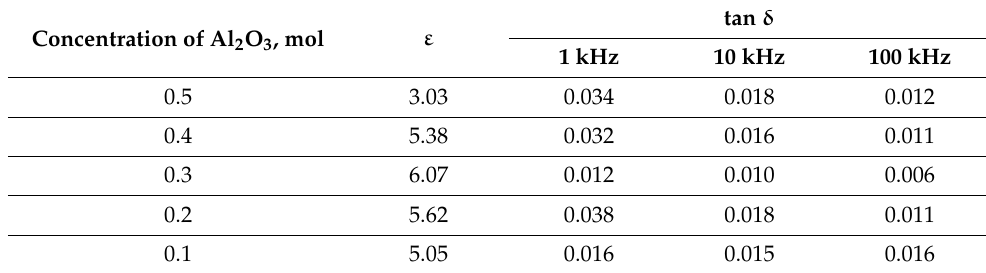
Table 2. Results of measurements of dielectric parameters ε , tan δ of the obtained samples.